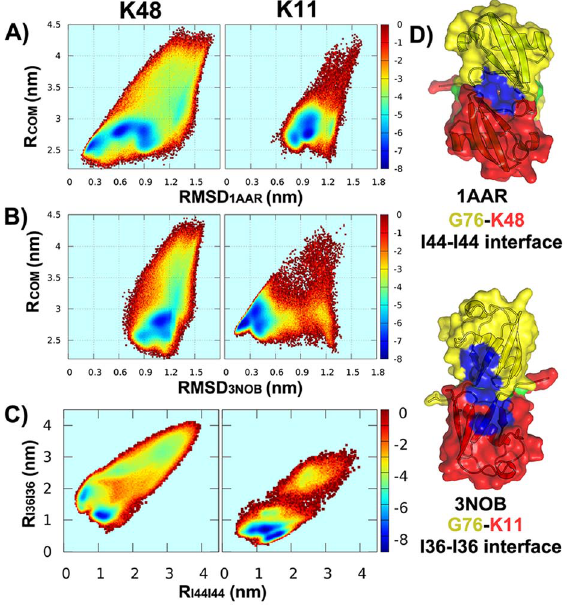
Figure 6. A significant distinct free energy landscape of K11- diUb from that of K48-diUb. (A) Free energy profiles as a function of R COM and RMSD from the X-ray structure of the closed form of K48- diUb ( RMSD 1 AAR ). (B) Free energy profiles as a function of R COM and RMSD from the X-ray structure of the compact form of K11-diUb ( RMSD 3 NOB ). (C) Free energy profiles as a function of the distance between I36 hydrophobic patches ( R I 36 I 36 ) and the distance between I44 hydrophobic patches ( R I 44 I 44 ) (D) Distribution of average interfacial contacts along the residue index of proximal Ub (black) and distal Ub (grey). Note that the results of K48-diUb model and K11-diUb model correspond to left and right subfigures, respectively.